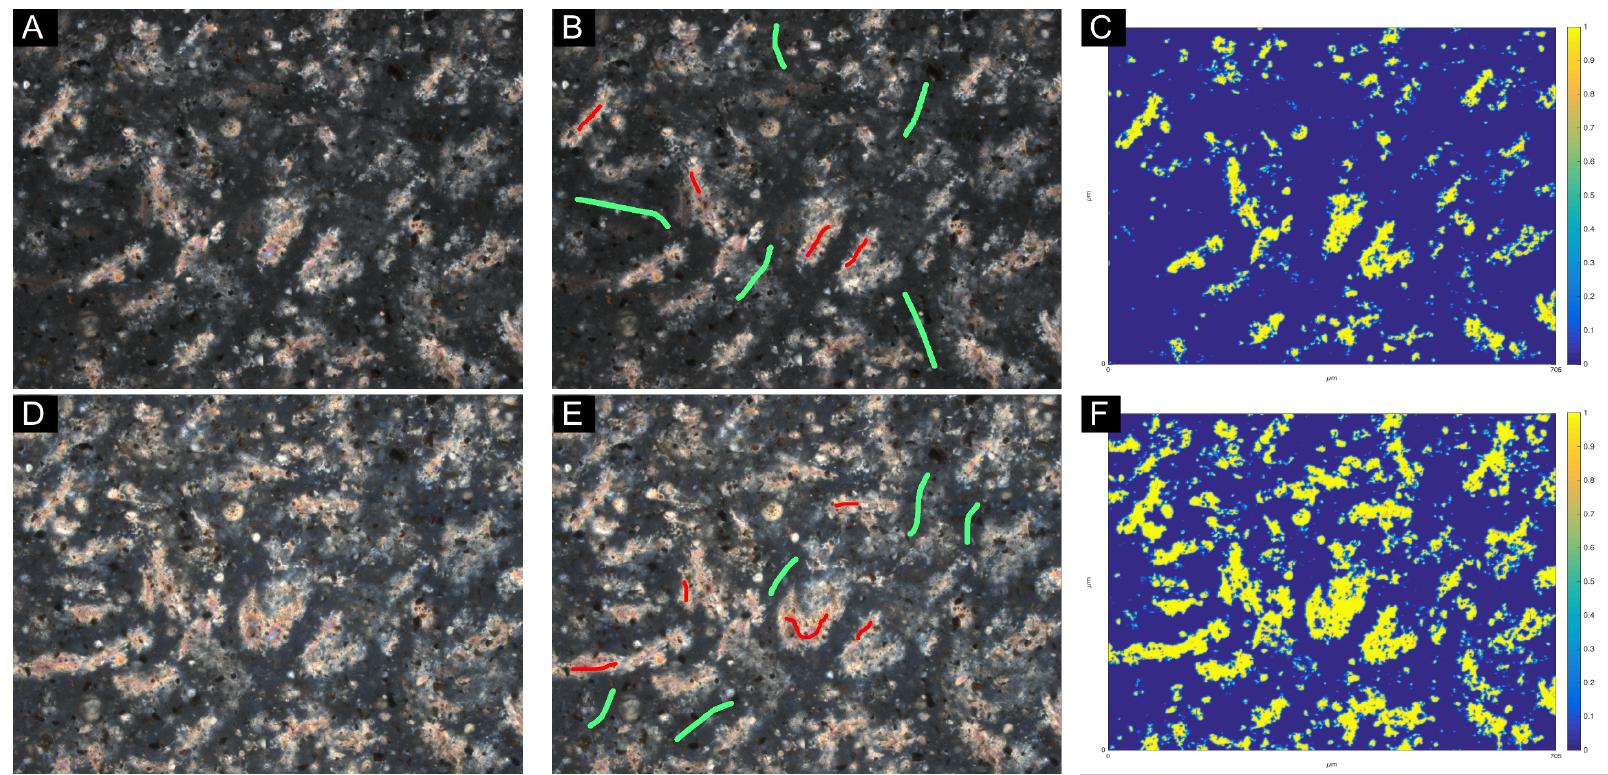
Figure 3. Portlandite cluster segmentation on optical photomicrographs with Trainable Weka Segmentation. Top row: ( A ) crossed-polarized light (XPL) image of the cement paste, W/C= 0.60; ( B ) an example class annotation for the Weka segmentation training; ( C ) segmented XPL image. Bottom row: ( D ) circular polarized light (CPL) image of the same field of view as the XPL; ( E ) an example class annotation for Weka segmentation training; ( F ) segmented CPL image. Note: the color scale denotes the probability of pixels segmented as portlandite, based on the classifier used. The field of view of all images is 705 µ